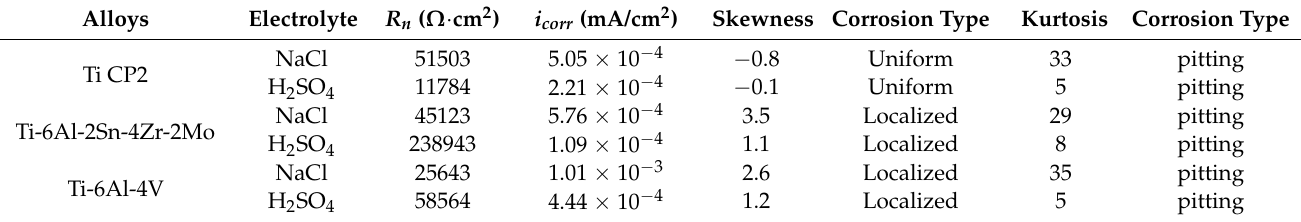
Table 3. EN statistical parameters from different alloys and